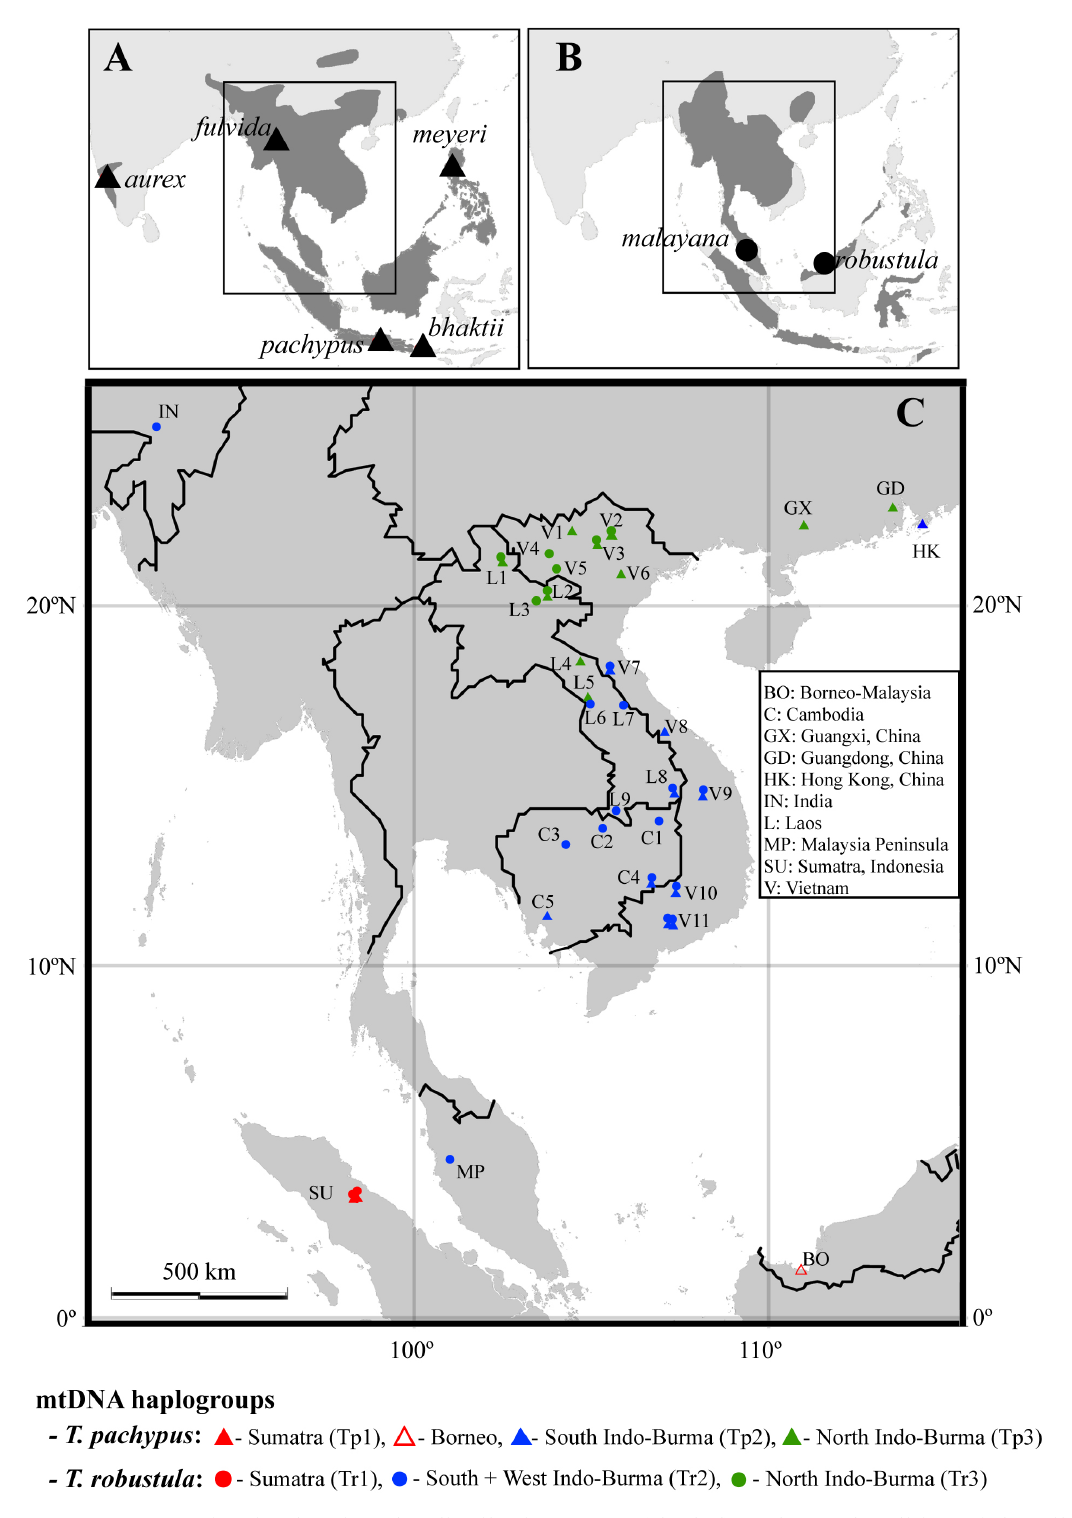
Fig. 1. A–B . Maps of Asia showing the distribution range (shaded) and type localities of described subspecies of T. pachypus (Temminck, 1840) and T. robustula Thomas, 1915 (Bates et al . 2008a, 2008b). C . Localities of Tylonycteris specimens included in this study. Triangles and circles refer to T. pachypus and T. robustula , respectively; the colours indicate the mtDNA haplogroups found in the Bayesian analyses of COI and Cytb sequences (see Fig. 2 for